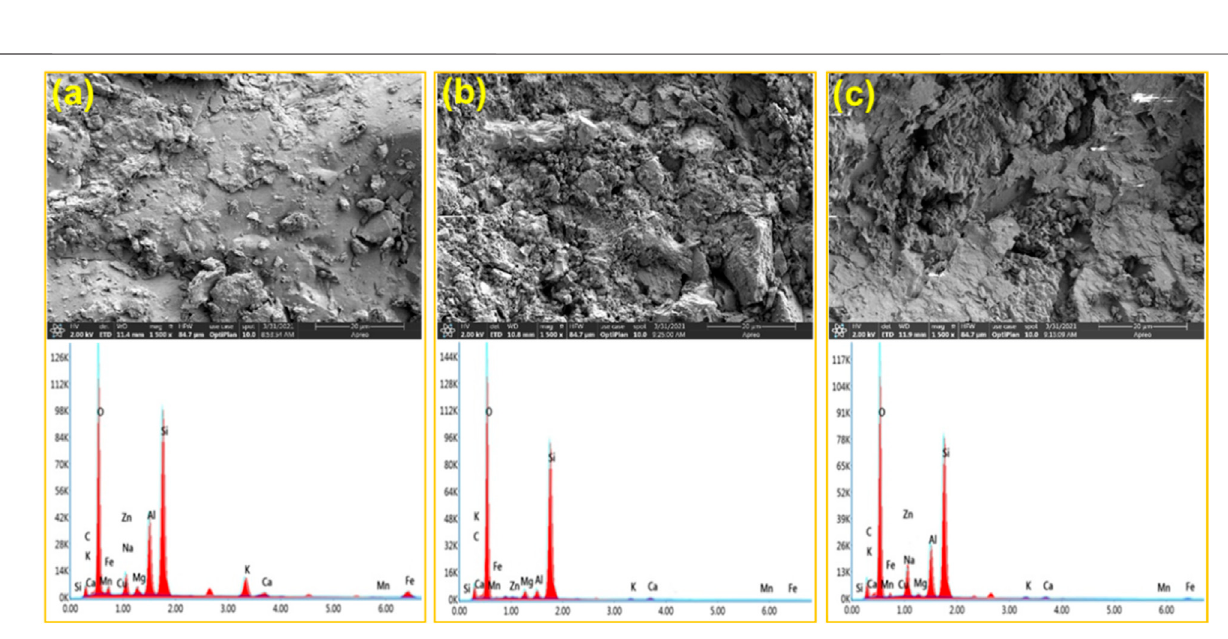
Frontiers in Chemistry |